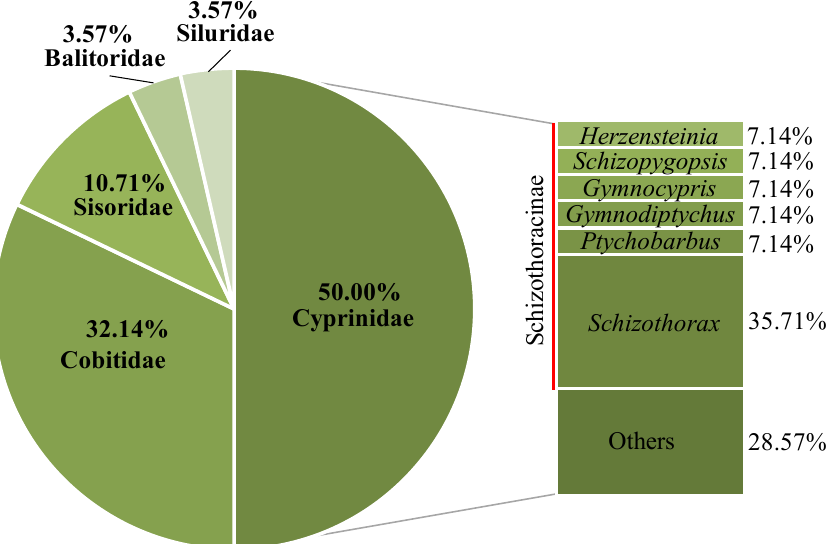
Figure 2. Proportion of fish families in the upper reaches of the Jinsha River.